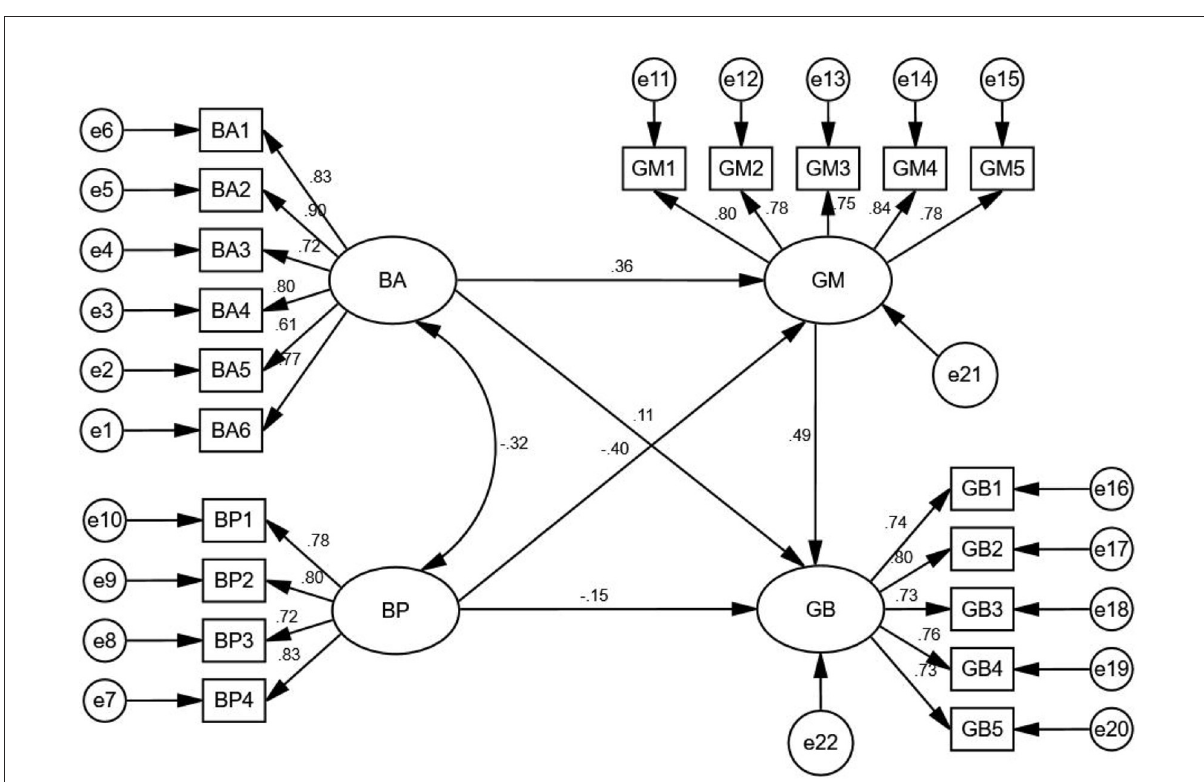
FIGURE3 Model path